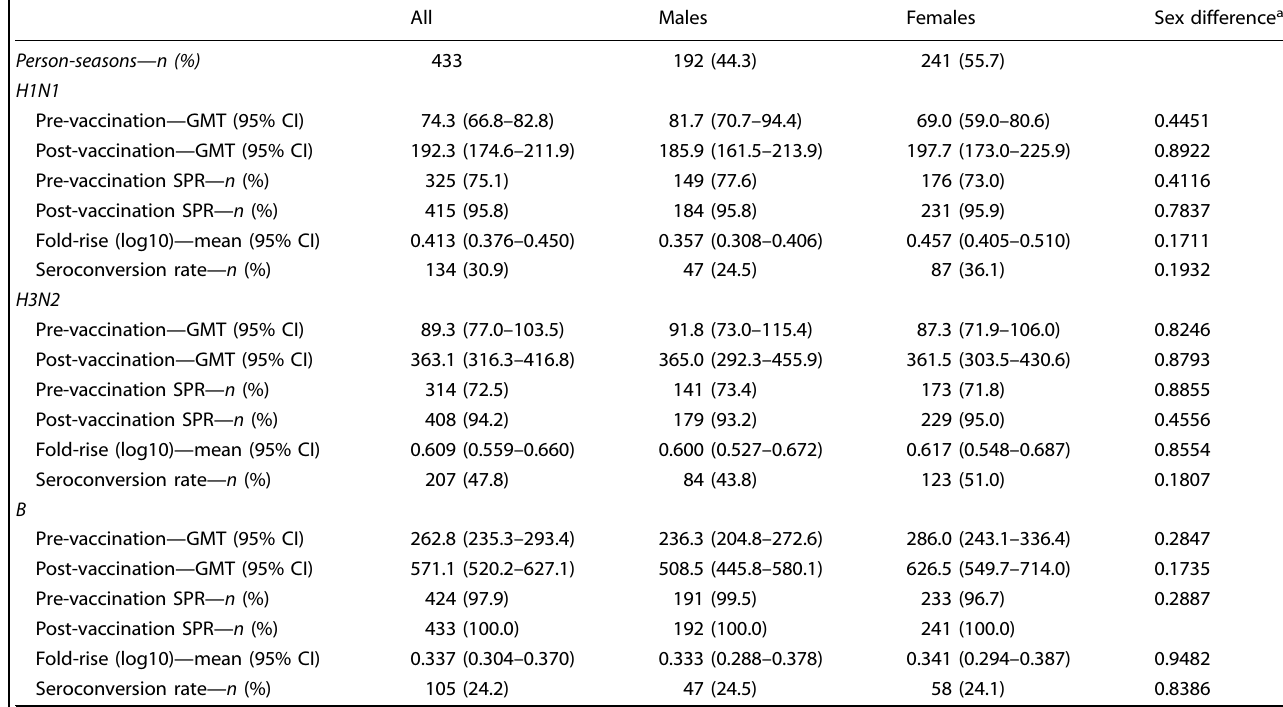
Table 2. Pre- and post-vaccination hemagglutination antibody inhibition (HAI) titer outcomes. All